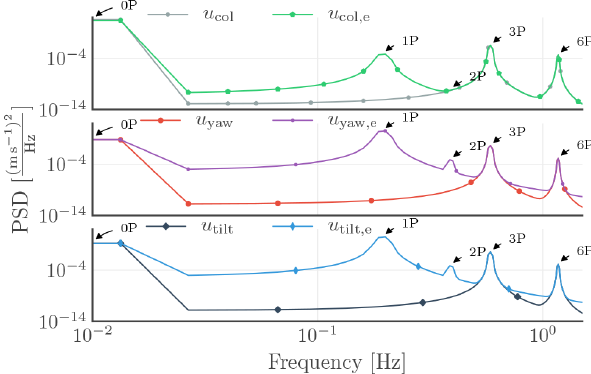
Figure 9. Power spectral densities of collective, yaw, and tilt com- ponents of the generic signals with partial DC offset and phase shift. The expression u ..., e indicates the case where a different DC offset is set and a 1 ◦ phase shift is added to the 1 P harmonics of one of the blade signals in the rotating frame of